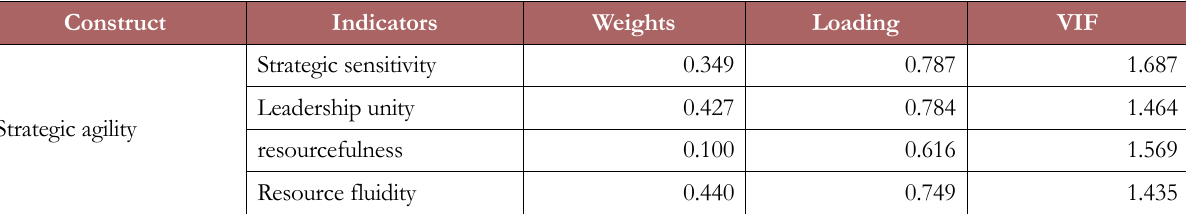
Table 13. Measurement model for composite